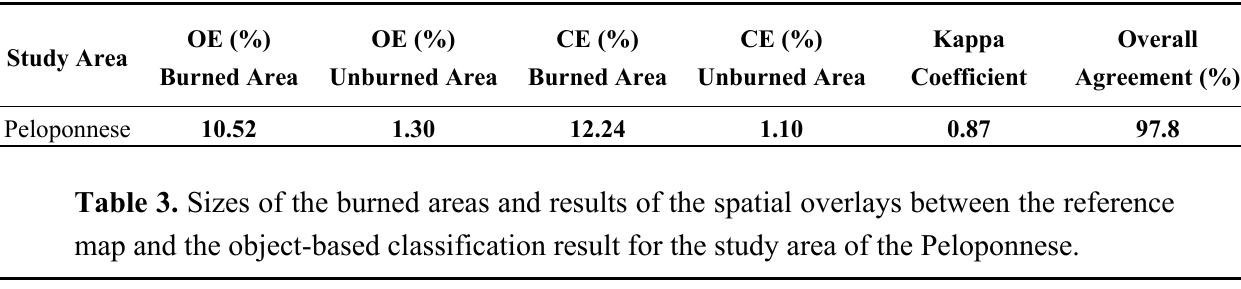
Table 2. Omission (OE) and Commission (CE) errors for burned and unburned areas, kappa coefficients and overall agreement for the study area of the Peloponnese.